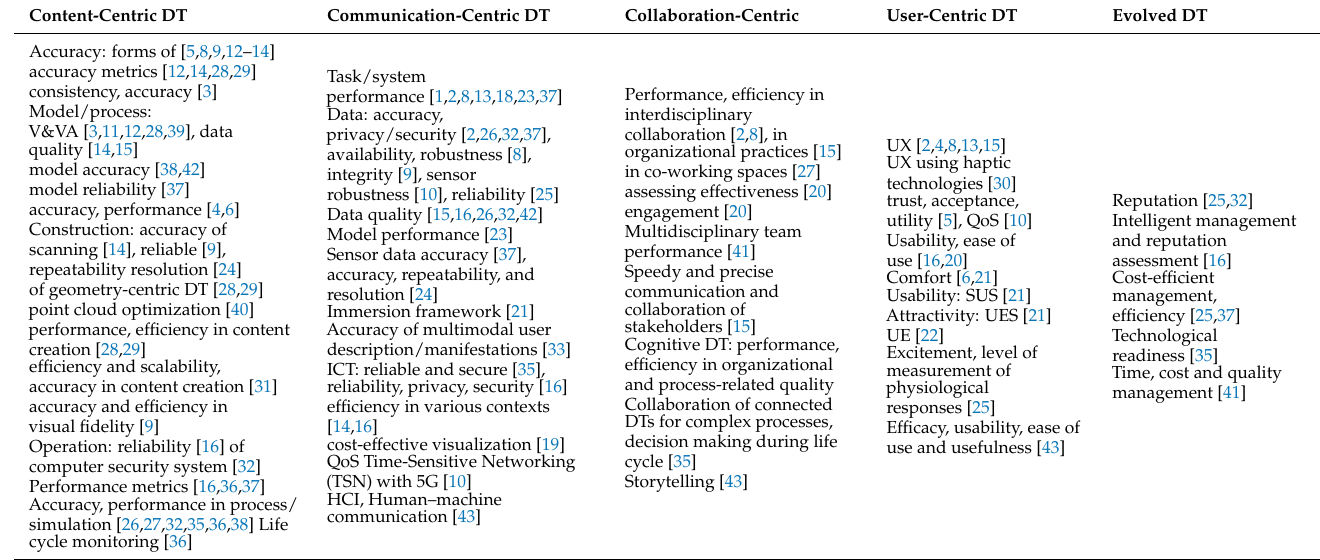
Table 4. Cont . Communication-Centric